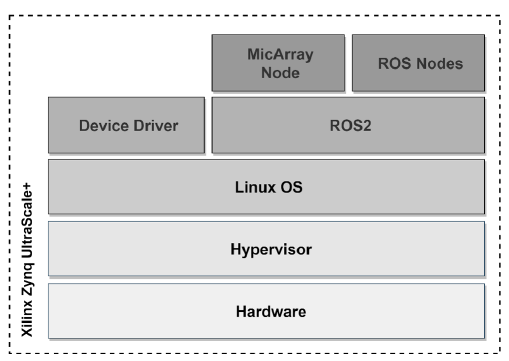
Figure 7. System software